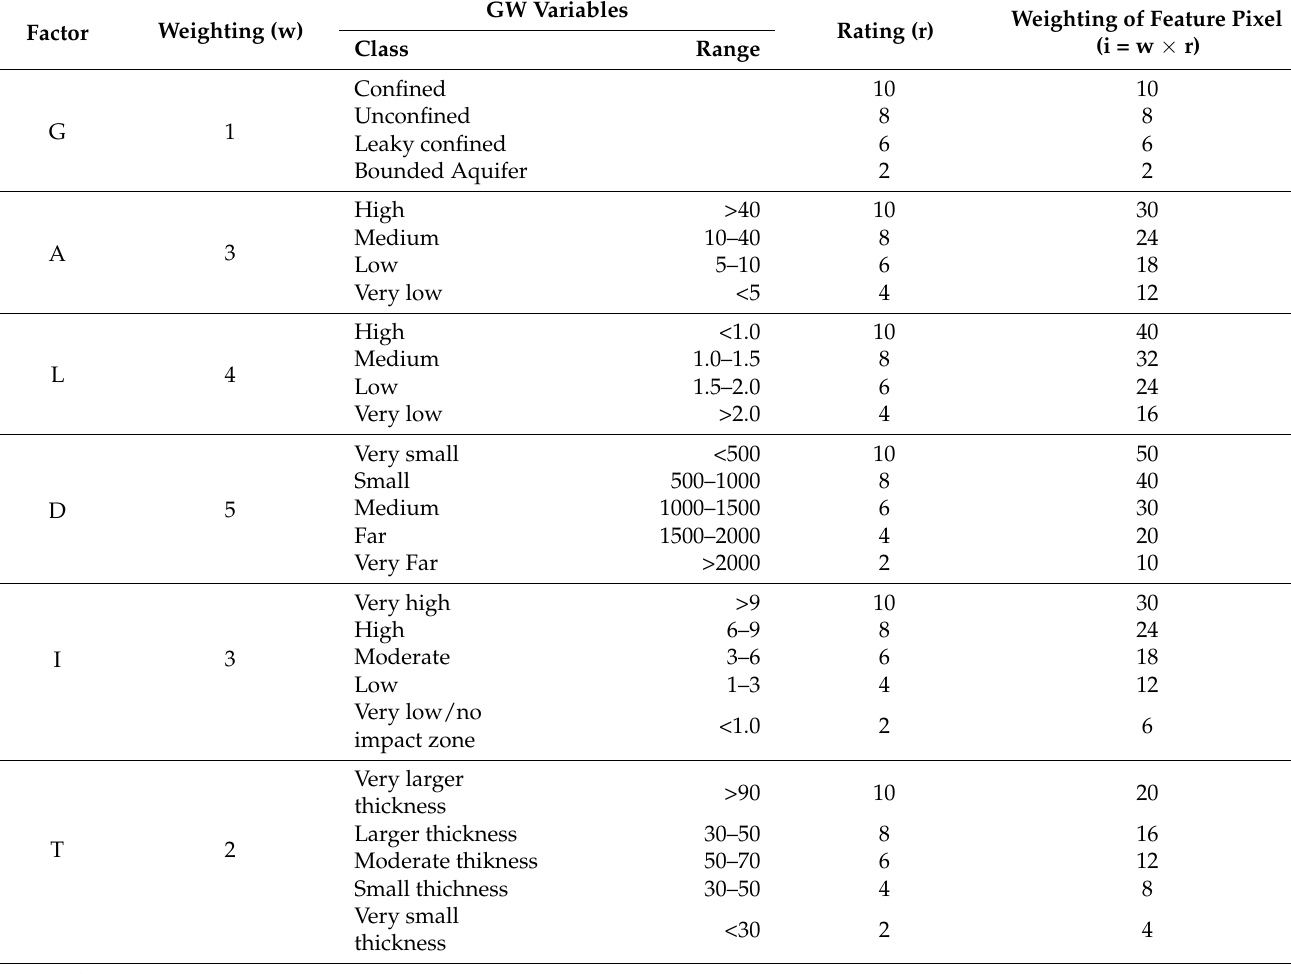
Table 2. Parameters of the GALDIT index used for Korba SWI vulnerability assessment